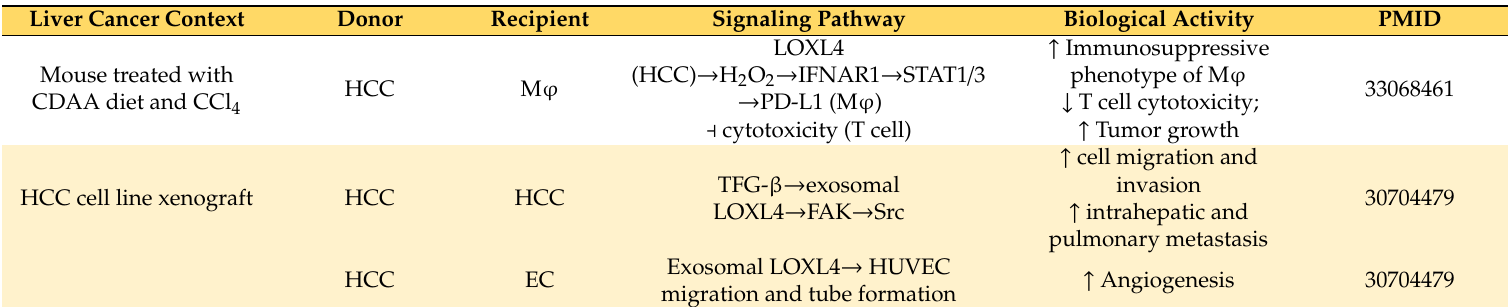
Table 4. Roles and mechanisms of LOXL4 in hepatocarcinogenic progression and the